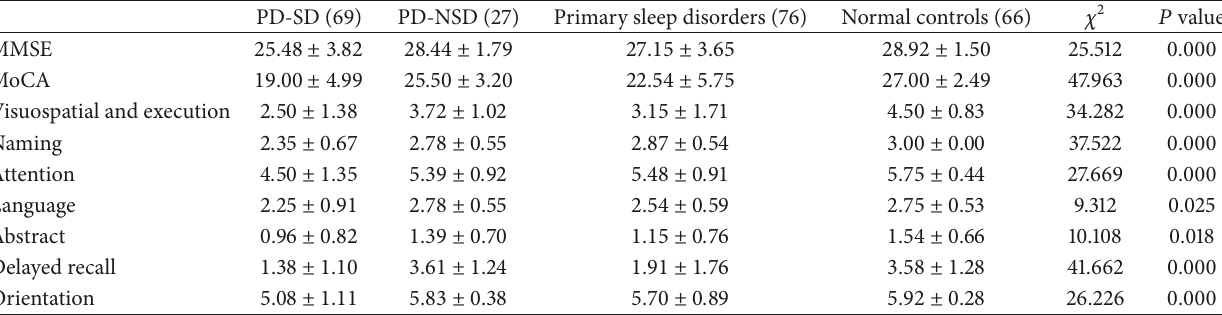
Table 3: Cognitive function characteristic analysis comparing the PD-SD, PD-NSD, primary sleep disorder, and normal control